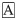
Example of head A, profile B, and dorsal C image perspectives of an Odontomachus chelifer specimen.Ant specimen photographs by April Nobile. Taken from www.antweb.org.